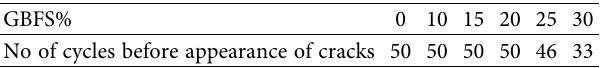
Table 2: Effect of percent GBFS on number of freezing–thawing cycles with No